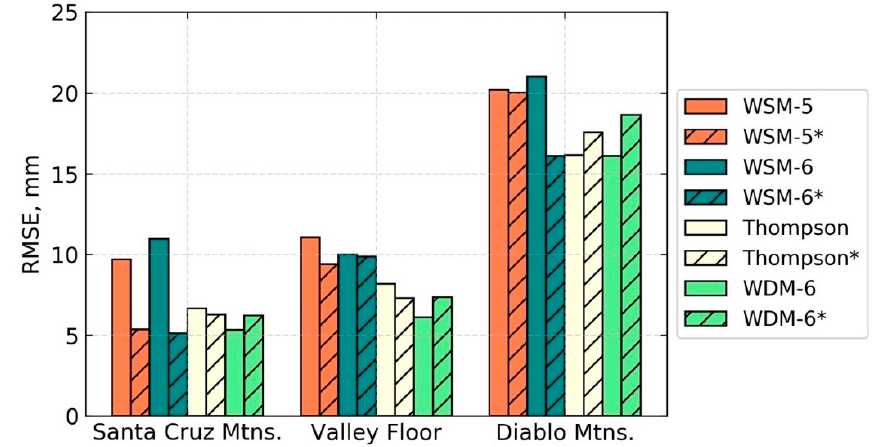
Figure 13. Accumulated precipitation root-mean-squared-error for both AR events. * denotes 1/3 km resolution.